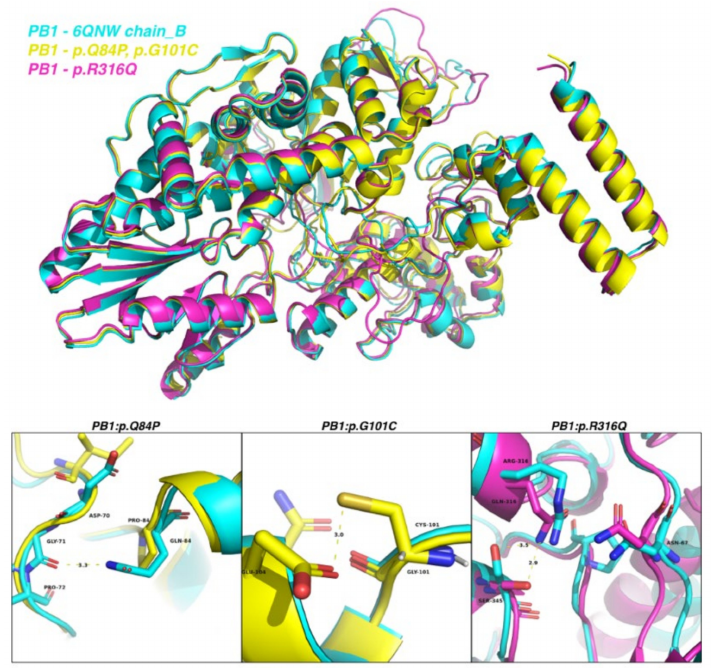
Figure 8. The superimposed structures of the PB1 protein of A/Northern Territory/60/1968 (cyan), PB1 with the Q84P and G101C mutations (yellow), and PB1 with the R316Q mutation (magenta). Magnified views of residues 84, 101, and 316 are depicted in the lower panel. Residues 84, 101, and 316 and their nearby residues are labeled in black, together with the distances in Angstrom (Å) units. Table 2. Comparison of titers of neutralizing antibodies against MDCK-SIAT1 passage P0 and P5 viruses in a panel of influenza-immune sera from 20